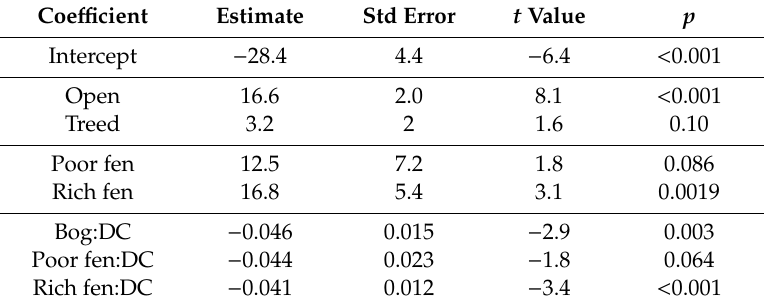
Table A2. ANCOVA general linear model for predicting water table depth (cm below surface) from peatland canopy cover, nutrient class, and the interaction between nutrient class and Drought Code. Note that for this GLM, the intercept-only case is a forested bog, so no coe ffi cients are given for bogs or forested peatlands (integrated into intercept). This model captures 52% of the variance in the